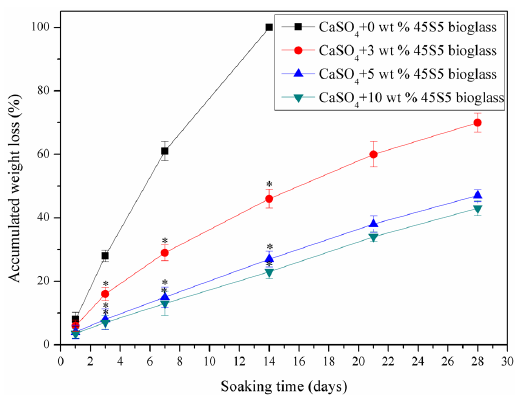
Figure 7. Accumulated weight loss of the specimens with different amounts of 45S5 bioglass after soaking in SBF for different durations. Statistically significant difference (* p < 0.05) from the specimens without bioglass.